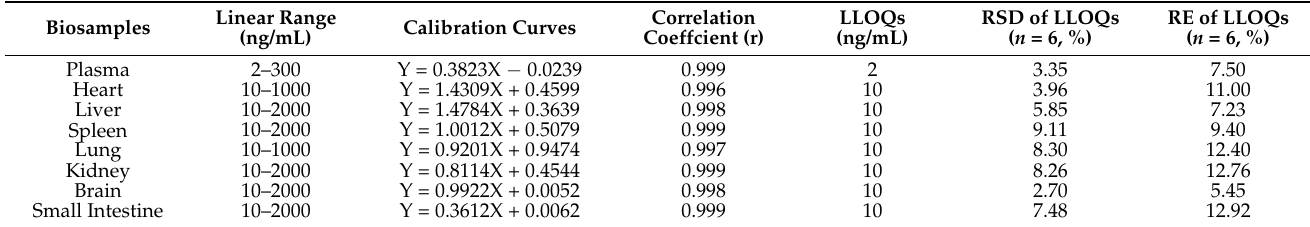
Table 1. Calibration curves of GAMG in different biological samples.